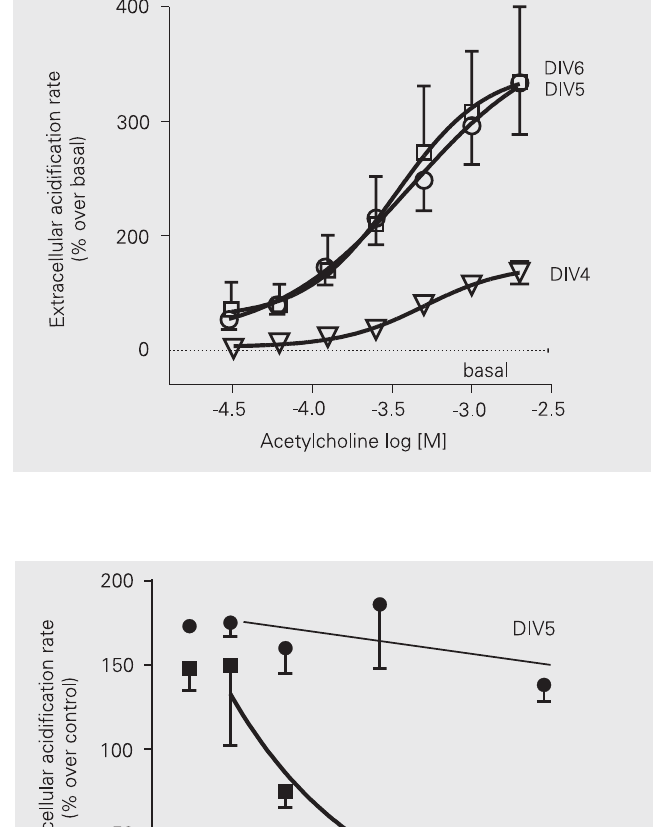
ANOVA).DH ßE log